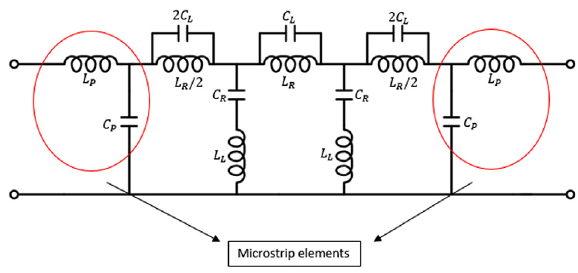
Figure 3. Schematic of a symmetric DL TL with two unit cells.